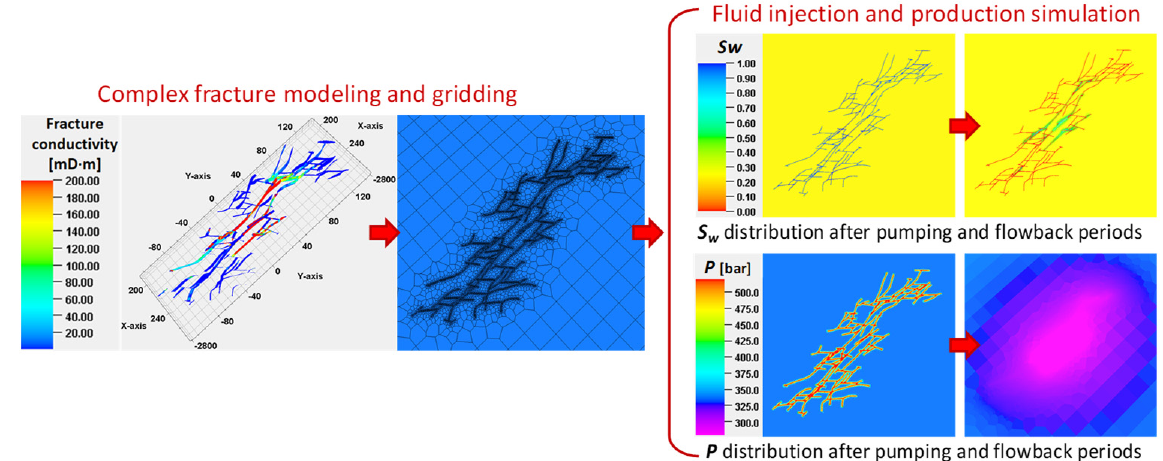
Figure 3. Numerical simulation workflow based on complex fracture modelling.